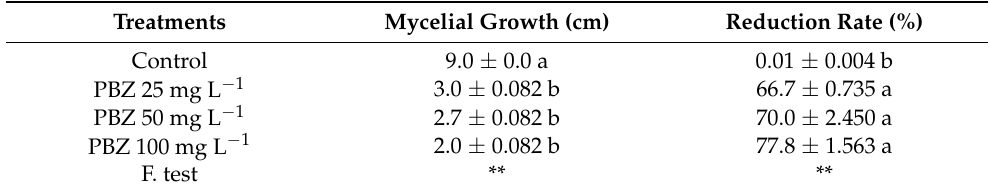
Table 2. The inhibition of Alternaria solani mycelial growth by PBZ application in different concentra- tions on PDA medium.